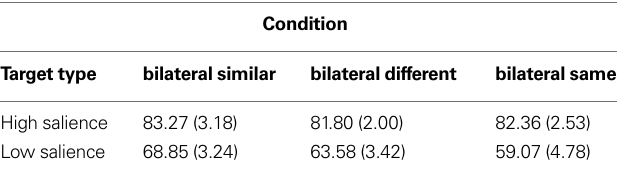
Table 1 | Mean accuracy (%) and normalized standard deviation (in brackets) for each bilateral condition for both the high salience and the low salience target stimulus.